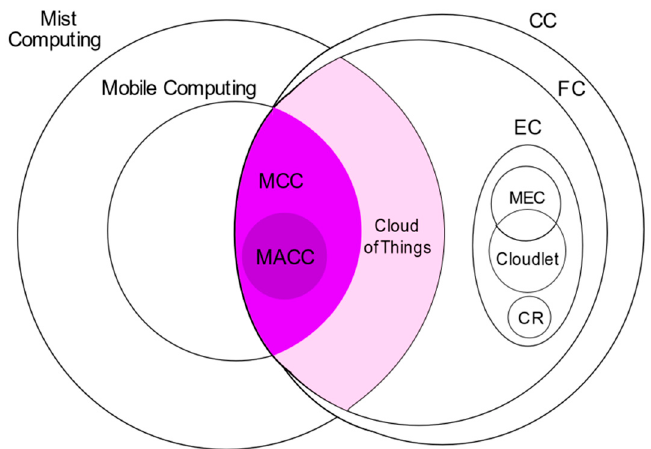
Figure 7. Fog computing and its related computing